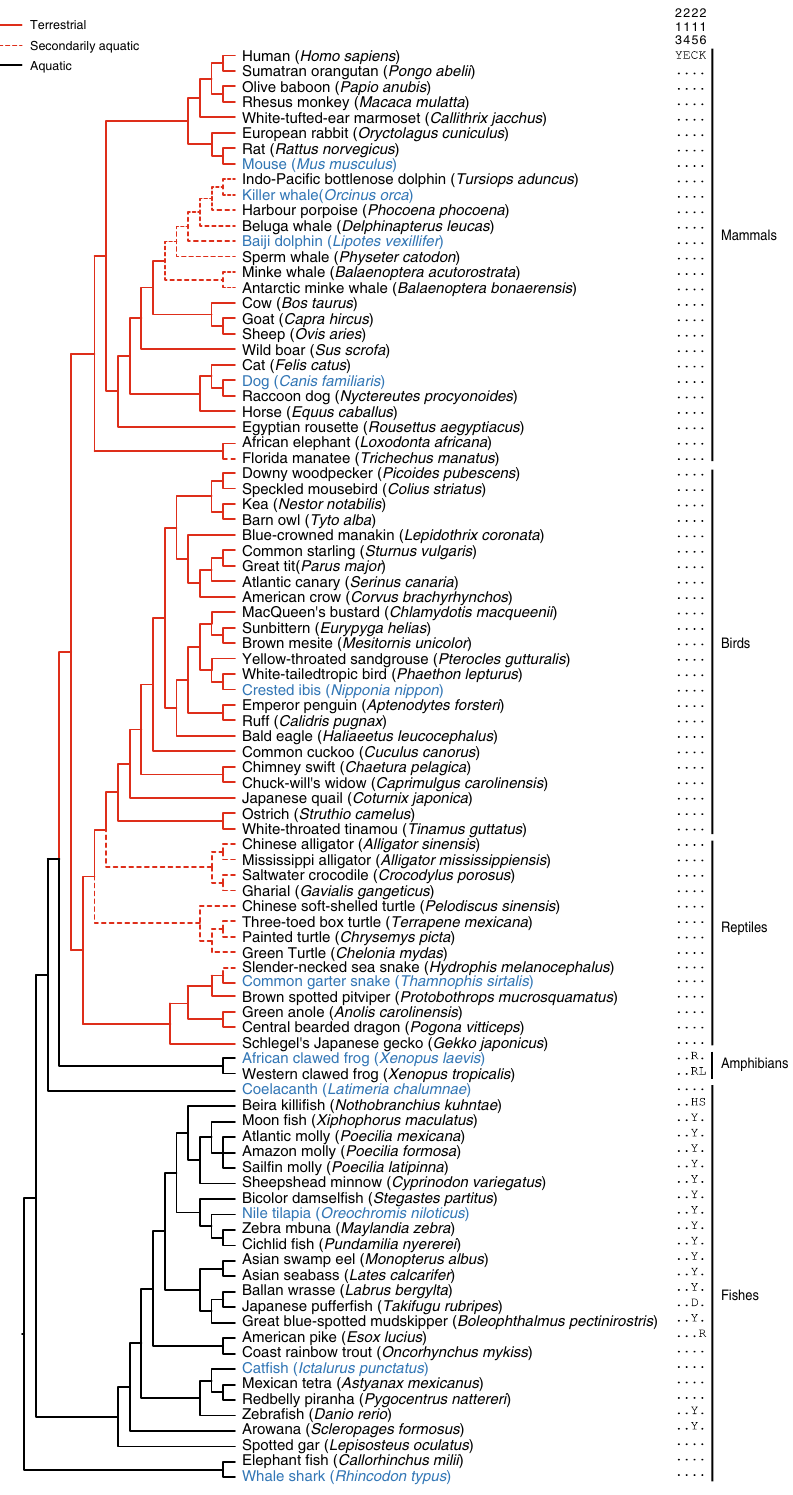
Fig. 6 Sequence conservation of Cys215 of Insig-2 in amniotes during evolution. The tree shows the YECK tetrapeptide sequence (amino acids position of 213 – 216) of Insig-2 is highly conserved in amniotes (93 species in 5 categories, indicated by red lines), including secondarily aquatic cetaceans (indicated by red dashed lines), but not in aquatic amphibians and fi shes (indicated by black lines). The species in blue were tested for their Insig-2 regulation by ROS in Fig. 7b, from ubiquitylation-mediated degradation in proteasome. This oxidation-ubiquitylation competitive mechanism explains the muscle-speci fi c stabilization of Insig-2 and prevents muscle cells from lipid overaccumulation.